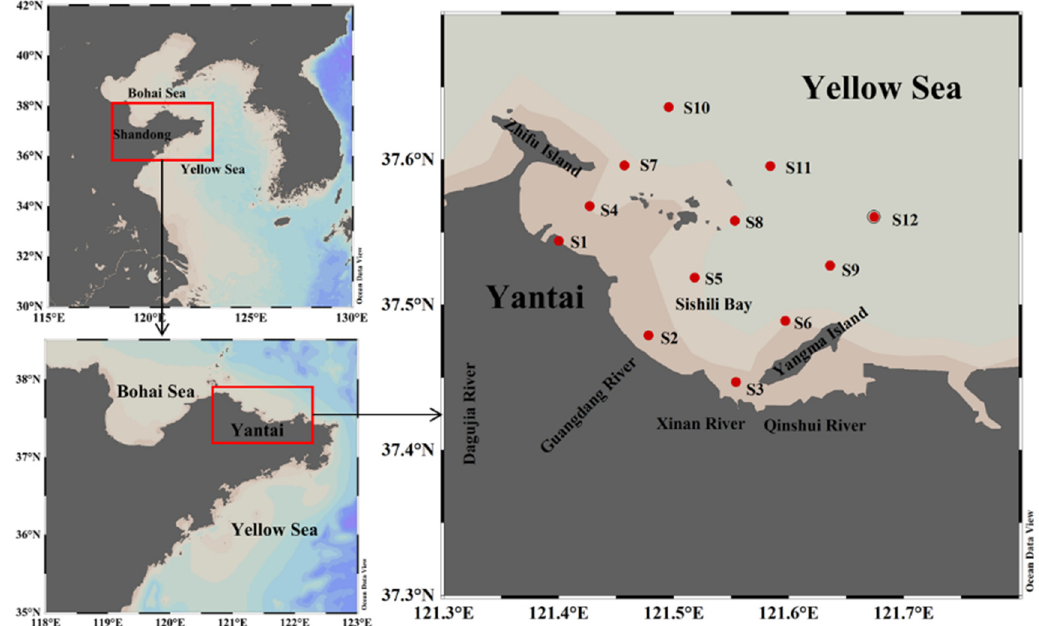
Figure 1. Locations of seawater sampling stations in Sishili Bay.